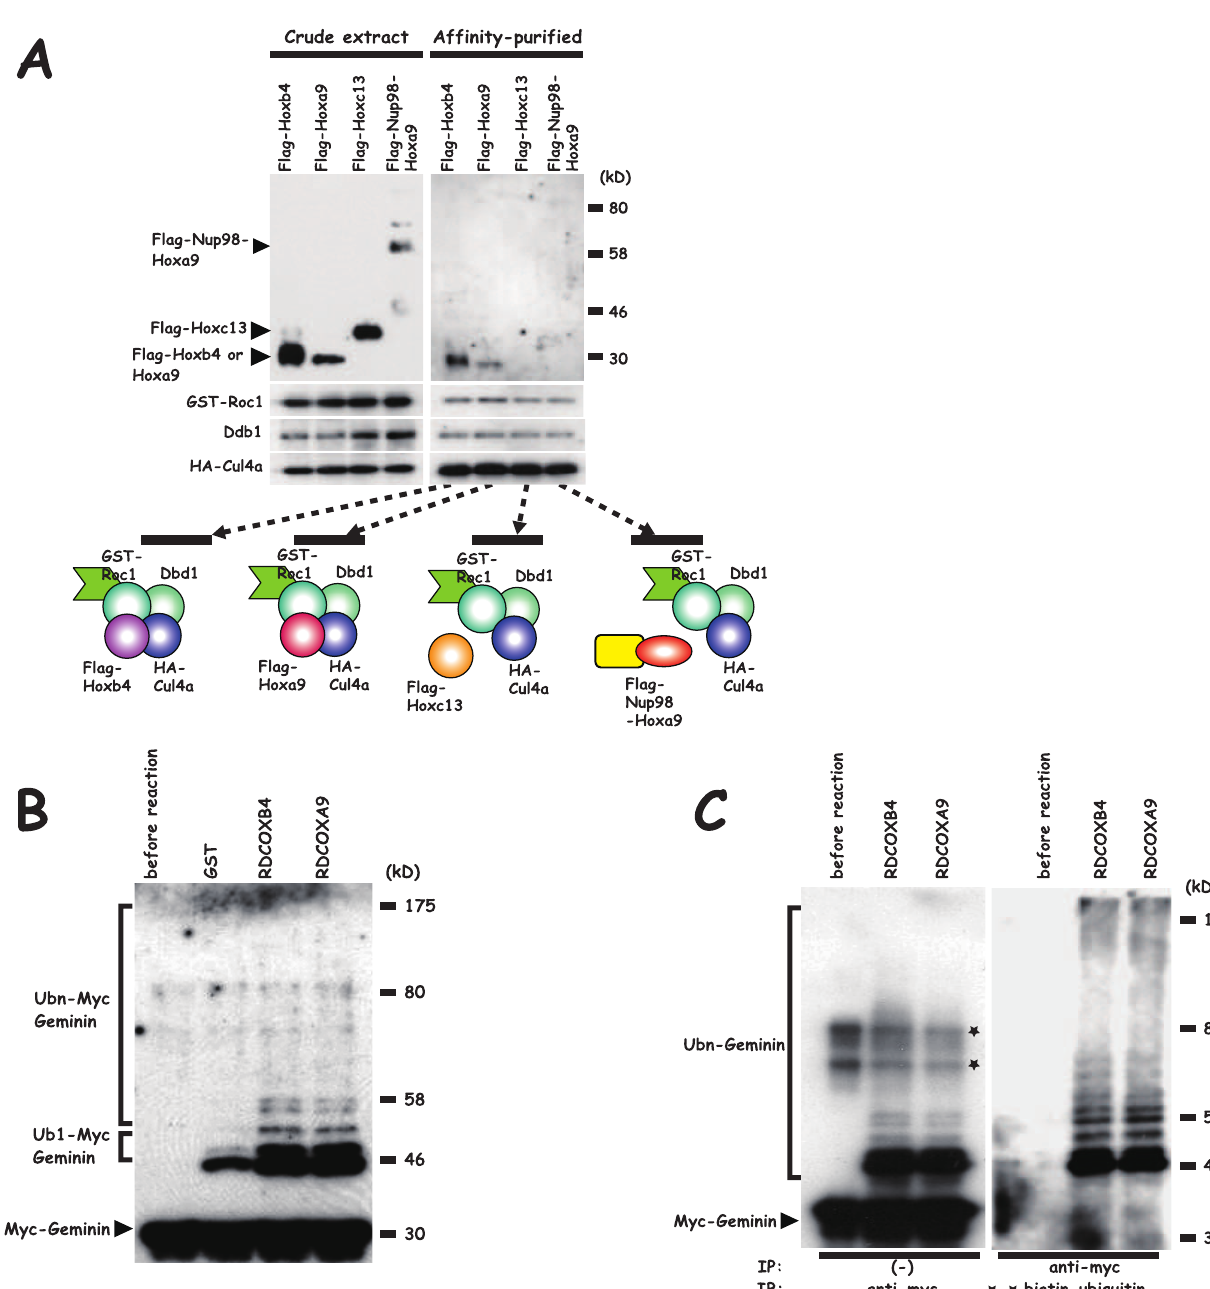
Figure 1. Purification of the recombinant RDCOXA9 complex from Sf9, and E3 ubiquitin ligase activity for Geminin. ( A ) Left panel: Crude extracts. Each member of the complex was detected in the crude extract by means of immunoblot analysis. Hox derivatives were detected with an anti-Flag antibody, GST-Roc1 with an anti-Roc1 antibody, Ddb1 with an anti-Ddb1 antibody and HA-Cul4a with an anti-HA antibody. Right panel: the affinity-purified. The complex with GST-Roc1 was pulled down with a glutathione affinity column chromatography. Each member was detected by means of immunoblot analysis in the pulled-down complex. Schematic representation of the complex is shown in the lower panel. The samples include GST-Roc1, Ddb1, HA-Cul4a and either of Flag-Hoxb4, Flag-Hoxa9, Flag-Hoxc13 or Flag-Nup98-Hoxa9. ( B ) E3 ubiquitin ligase activity for Geminin. The affinity-purified recombinant complex was subjected to in vitro ubiquitination reaction (myc-Geminin + E1 + E2 + ubiquitin), and the reaction product was analyzed by immunoblot analysis with an anti-myc antibody. The amount of GST-Roc1 in the RDCOXA9 complex was adjusted to that of the RDCOXB4 complex (1 m g). Ub1-Geminin, mono-ubiquitinated Geminin; Ubn-Geminin, poly-ubiquitinated Geminin. The mono- ubiquitinated Geminin bands were detected in this in vitro assay system even in the absence of E3 ubiquitin ligase (second lane). ( C ) In vitro ubiquitination reaction with biotin-tagged ubiquitin. myc-Geminin was immunoprecipitated with an anti-myc antibody after the reaction, and ubiquitinated Geminin was detected through biotin-avidin interaction. *, unspecified bands. **biotin-ubiquitin was detected with avidin vectastain.